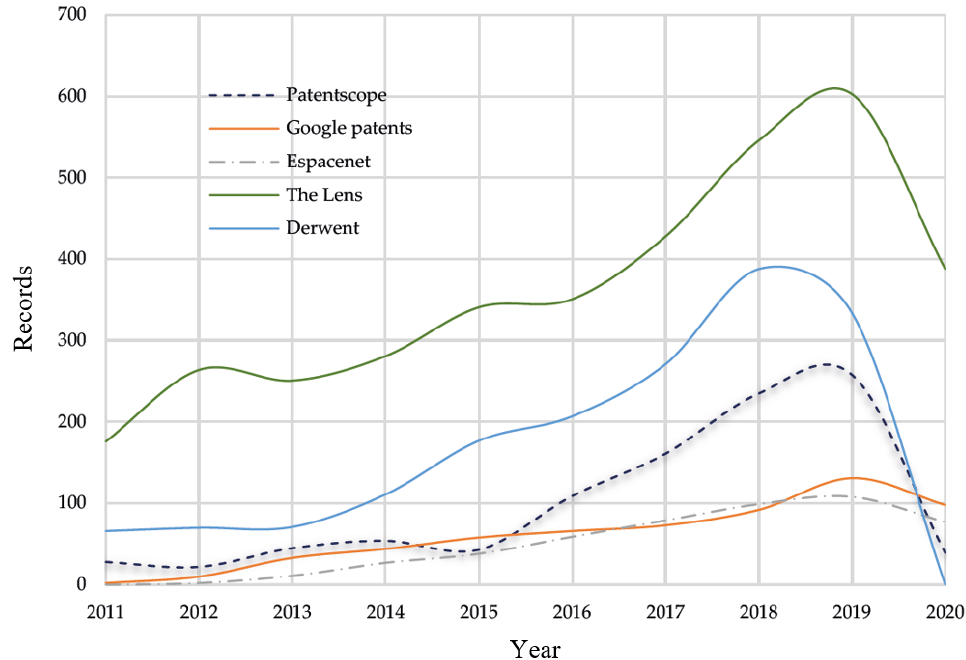
Figure 2. Documents by